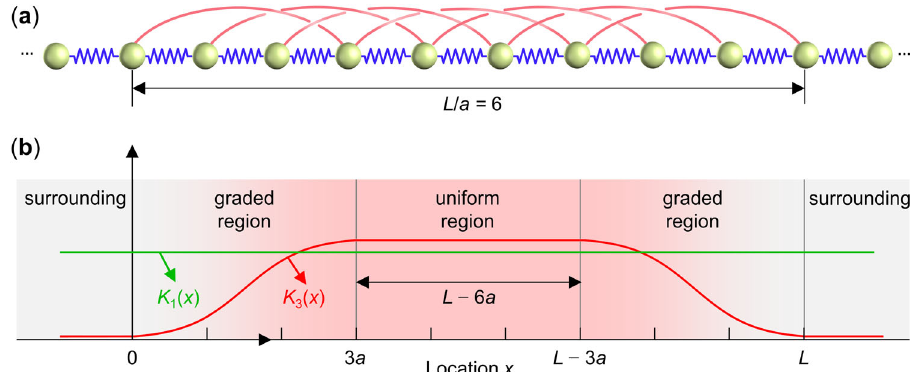
Fig. 5 Illustration of the effective-medium model. a Discrete system with slab thickness L . L ¼ 9 a is used as an example. b Scheme of the continuum model composed of the slab region and the two semi-in fi nite surroundings. The slab is further decomposed into a central uniform region, i.e., 3 a < x < L (cid:2) 3 a , and two graded regions, i.e., 0 < x < 3 a , and L (cid:2) 3 a < x < L . The graded regions represent smooth transitions of the effective parameters to those in the two surroundings. In the region of 0 < x < 3 a , a function that increases smoothly from an extremely small value to a fi nite value is assumed for K 3 ð x Þ , indicating the third-nearest-neighbor constants. K 3 ð x Þ for L (cid:2) 3 a < x < L is obtained from mirror symmetry of the system. For the central uniform part of the slab, i.e., 3 a < x < L (cid:2) 3 a , and the two surroundings, i.e., x < 0 and x > L , K 3 ð x Þ becomes constant and is obtained from continuity. The parameter K 1 ð x Þ is assumed to be constant throughout the 1D system, K 1 x ð Þ ¼ 1. The effective parameters of the continuum model are constructed from the two spring constants K 1 ð x Þ and K ð x Þ , i.e., from A x ð Þ ¼ K x ð Þ þ 9 K ð x Þ , A x ð Þ ¼ 6 K x ð Þ , and A x ð Þ ¼ K ð x Þ , 3 2 1 3 4 3 6 3